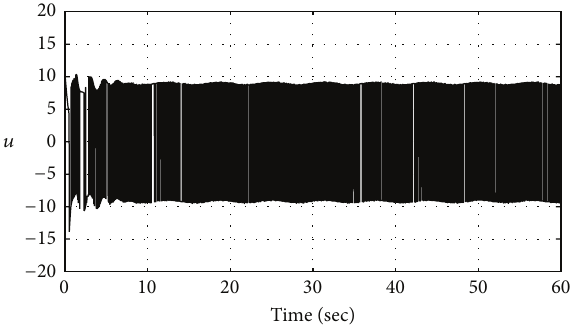
Figure 5: The control law 𝑢 .